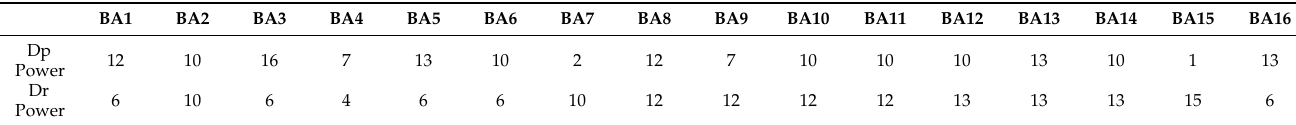
Table 16. Dependence power and driving power of the